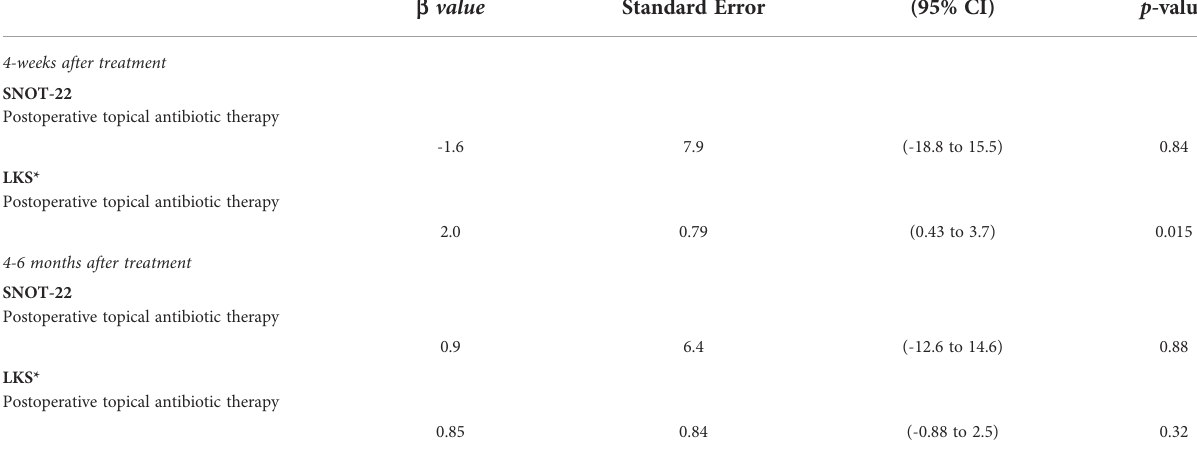
TABLE 4 Linear regression analysis of the effect of postoperative topical antibiotics on sinonasal outcomes over